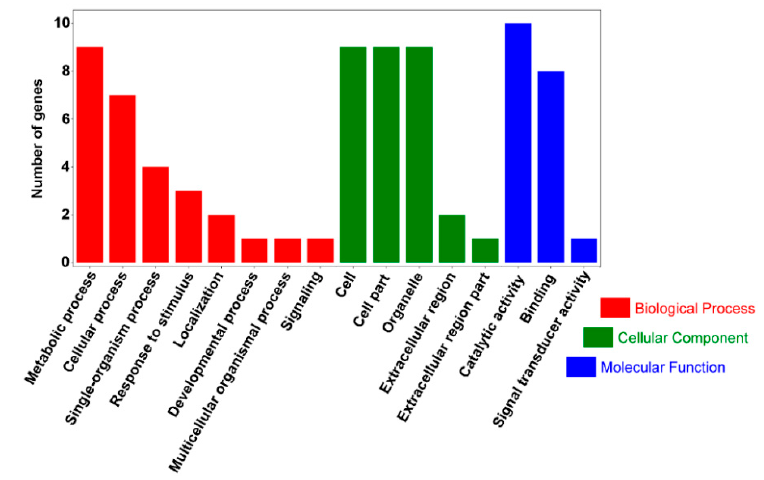
Figure 5. GO functional classification on DEGs for QCL5013 vs. QCL8004_1 and QCL5013 vs. QCL8004_2. Y axis means number of DEGs (the number is presented by its square root value). X axis represents GO terms. All GO terms are grouped into three ontologies: orange is for biological process, brown is for cellular component, and blue is for molecular function.